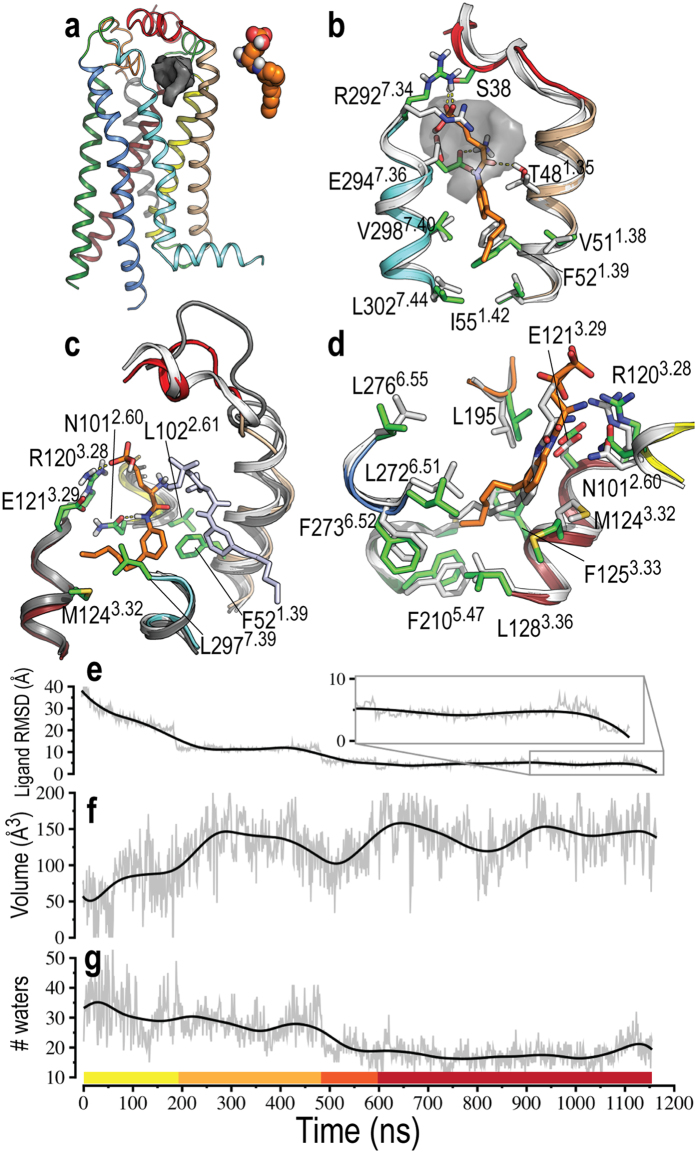
The pathway of ligand entry.The binding of ML056 to S1P1R can be subdivided into four steps (panels (a–d)). (a) ML056 (in orange spheres) diffuses from the bulk of the membrane toward an entrance channel (gray surface) in S1P1R (TM 1: wheat, TM 2: yellow, TM 3: dark red, TM 4: gray, TM 5: green, TM 6: blue, TM 7/helix 8: light blue, Nterm: red, ECL 2: orange). The simulation time of the ligand in this step is shown as a yellow bar in panel (g). (b) The polar head group of ML056 (orange sticks) is attracted to a “membrane vestibule” by the interaction of S38, T481.35, R2927.34 and E2947.36 (green sticks). The hydrophobic tail of the ligand is accommodated in a hydrophobic pocket between TMs 1 and 7. The entrance channel is shown as a transparent gray surface and the crystal structure of S1P1R is shown in white for comparison. The simulation time for this step is shown as an orange bar in panel (g). (c) ML056 (orange sticks) moves from the “membrane vestibule” (shown in light blue sticks for comparison purposes) to the entrance channel. The crystal structure of S1P1R and an earlier snapshot, in which the N-terminal helix is unfolded due to ligand entering the channel, are shown in white and gray, respectively. The simulation time for this step is shown as a dark orange bar in panel (g). (d) In the final step, ML056 enters the orthosteric binding cavity from the channel. The computationally-derived binding pose (orange and green sticks for ML056 and S1P1R, respectively) reproduced the main contacts observed in the crystal structure (white helices and sticks). The simulation time for this step is shown as a red bar in panel (g). (e) RMSD values of ML056, relative to the bound-pose observed in the crystal structure, along the MD trajectory. (f) Volume of the cavity (gray surface in panels (a,b)), forming the entrance channel, along the MD trajectory as calculated with POVME18. (g) Number of water molecules within 5 Å of ML056 along the MD trajectory.